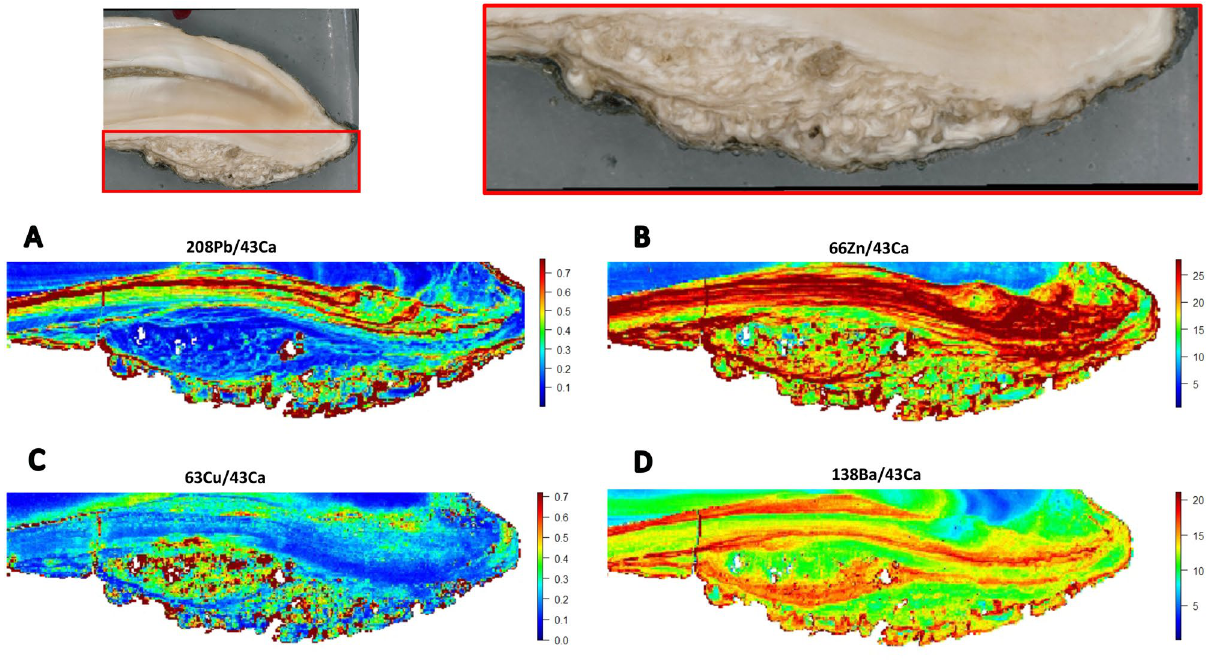
Figure 5. Second example of elemental dysregulation in EOTRH. Elemental maps of analyzed regions of a second tooth with hypercementosis (region outlined in red in top panels) is shown. Maps for lead ( A ), zinc ( B ), copper ( C ) and barium ( D ). Similar to the tooth shown in Fig. 4, there was hyperaccumulation of trace elements in the irregular hypercementosis-affected region and disrupted incremental growth